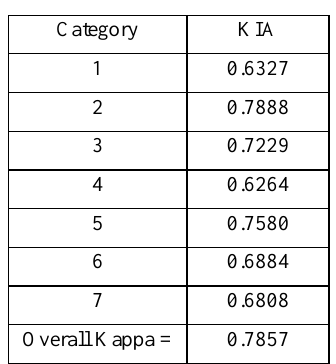
Table 6. Accuracy assessment for each categories of simulated